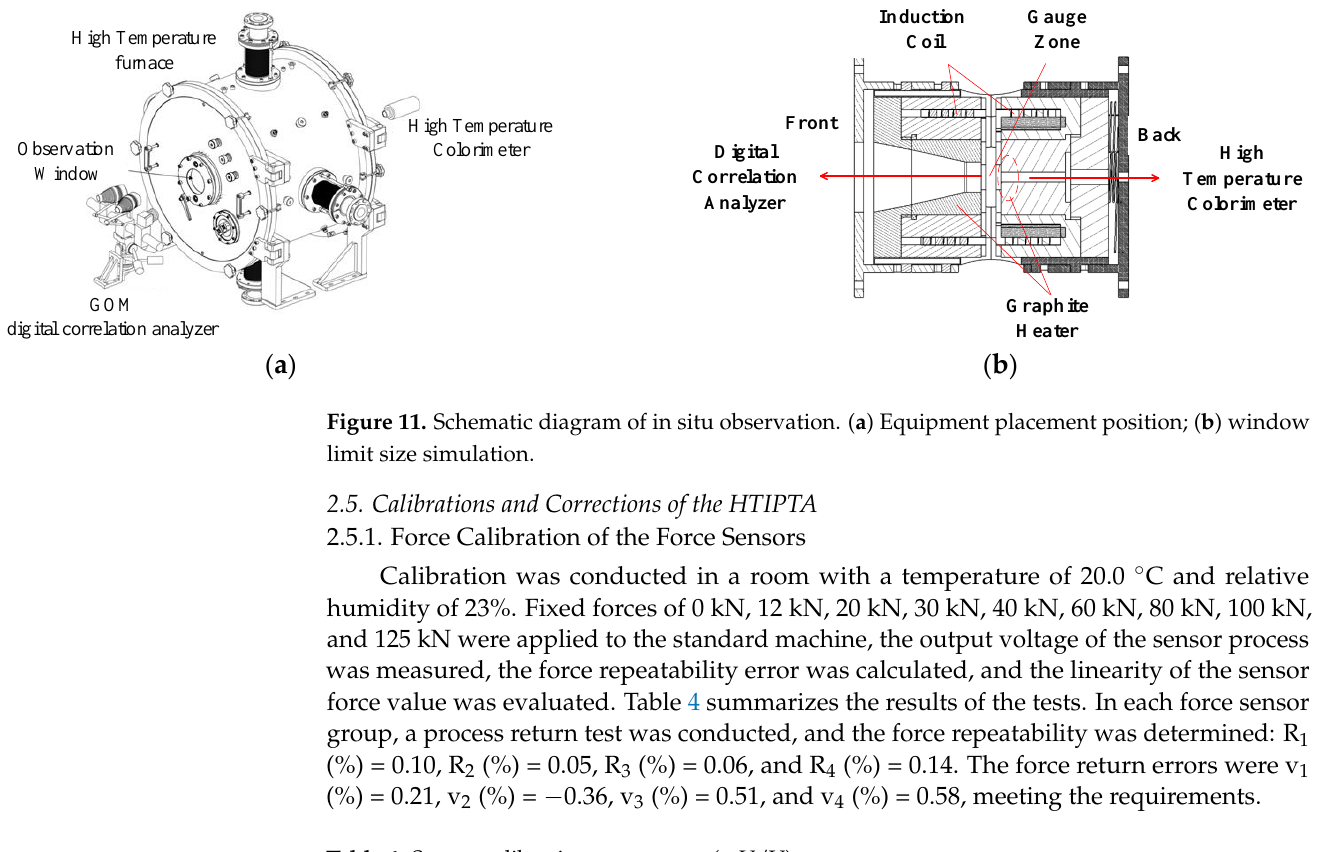
Table 4. Sensor calibration parameters